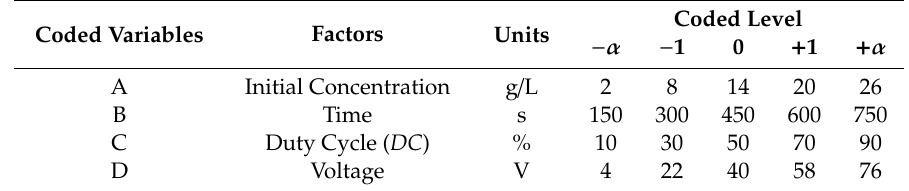
Table 1. Experimental range and levels of independent factors used in Central Composite Design